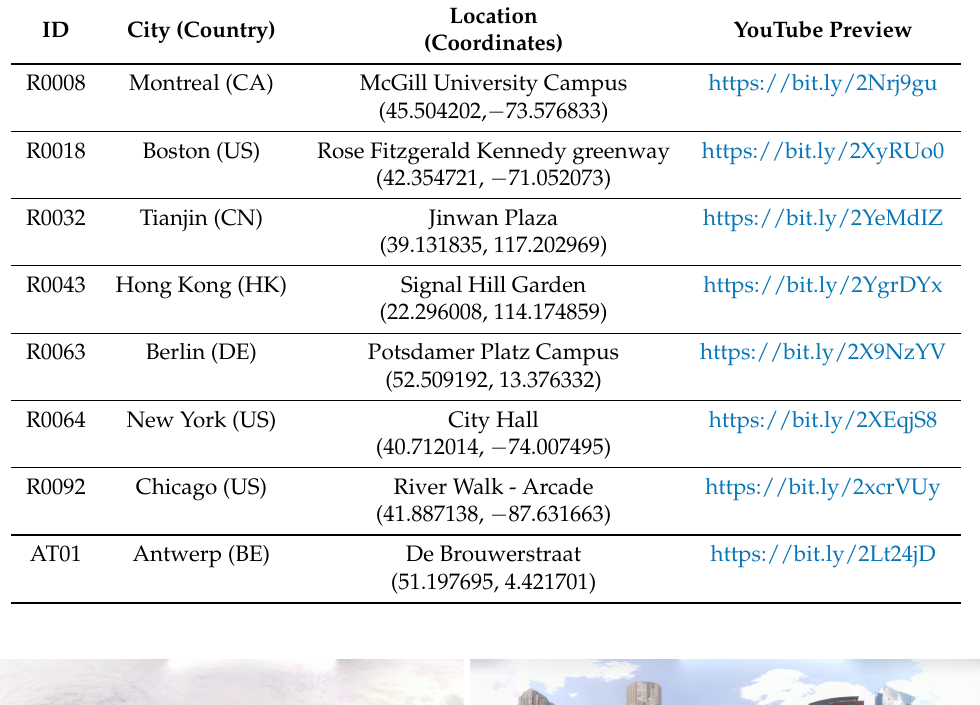
Table 2. Overview of the recording